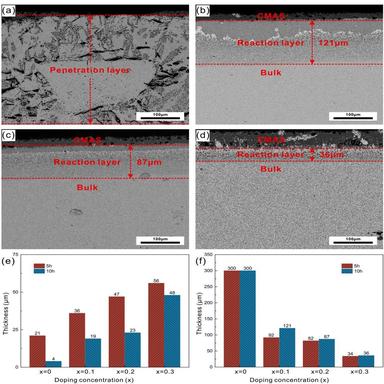
Cross-sectional backscattered electron SEM images of (Y1-xLax)3Al5O12 samples after CMAS corrosion at 1250 ◦C for 10 h: (a) x = 0, (b) x = 0.1, (c) x = 0.2, (d) x = 0.3, (e) thicknesses of the residual CMAS layer for (Y1-xLax)3Al5O12 (x = 0, 0.1, 0.2, 0.3) samples, (f) thicknesses of the reaction layer for (Y1-xLax)3Al5O12 (x = 0, 0.1, 0.2, 0.3) samples.